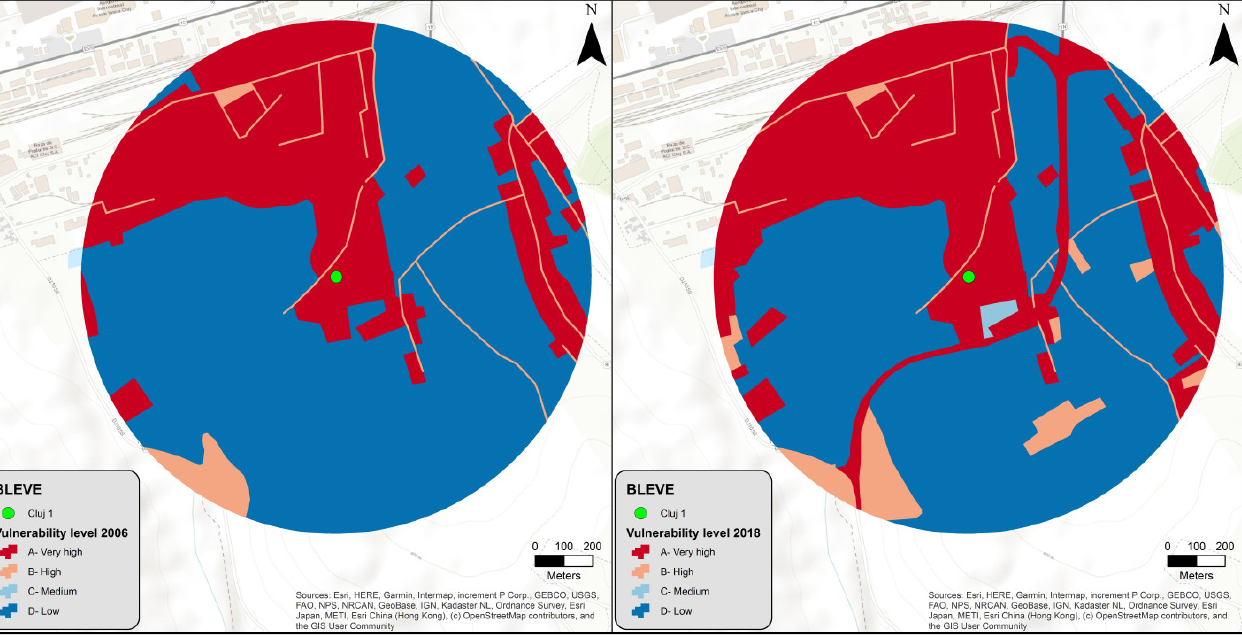
Figure 9. Vulnerability temporal variation within the reversible effects area for Cluj 1- worst-case scenario (BLEVE).